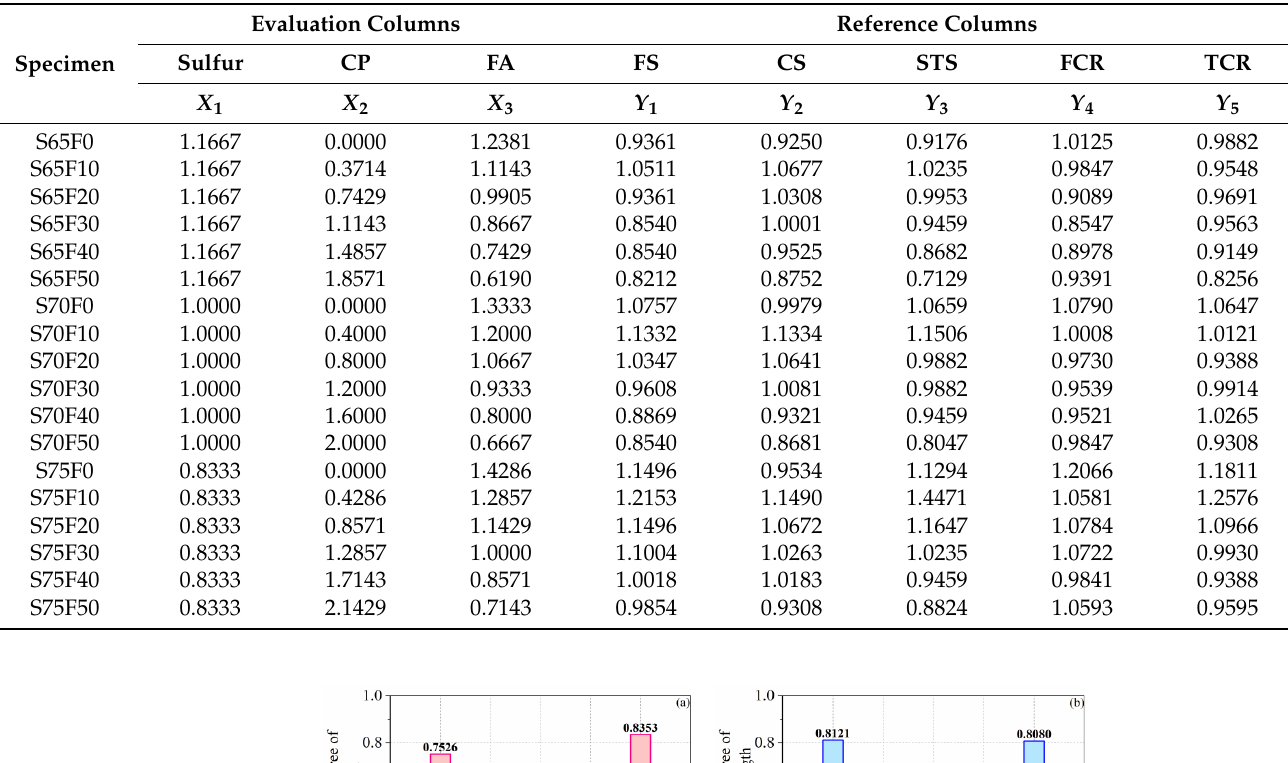
Table 6. Results of mean processing.